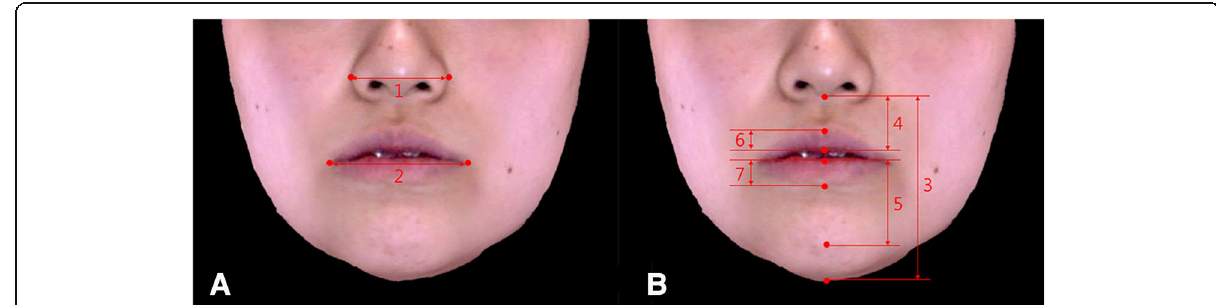
Fig. 4 Soft tissue linear measurements. a 1. Nasal width (Al dev – Al ctl), 2. Lip width (Ch dev – Ch ctl). b 3. Lower facial height (Sn – Me ’ ), 4. Upper lip height (Sn – Stms), 5. Lower lip height (Stmi – Pog ’ ), 6. Upper vermilion height (Ls – Stms), and 7. Lower vermilion height (Li – stmi). See also Table 3 for the description of soft tissue linear